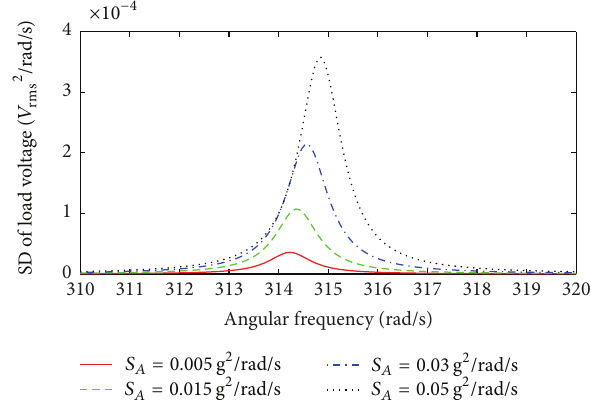
Figure 10: SD of the load voltage as a function of angular frequency for high levels of broad band Gaussian white noise random excita- tion; scaling factor 𝜂 = 5 m −2